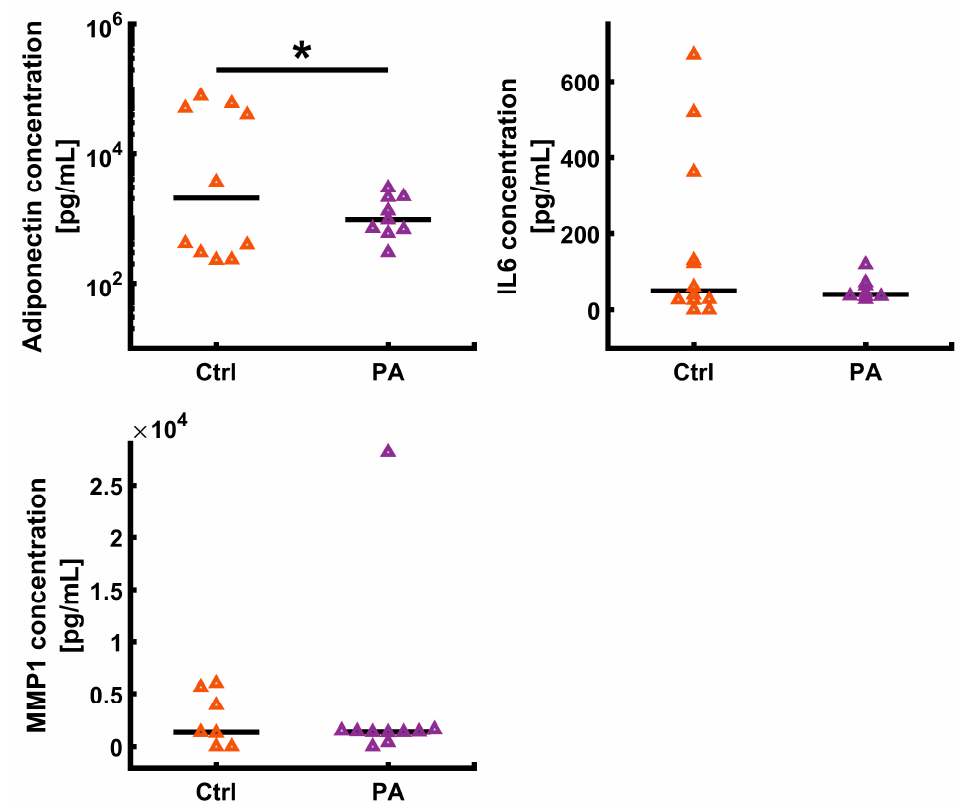
Figure 3. Cytokine evaluation from cell media was completed via ELISA. Cell media was collected after week 8 of culture. All values were corrected by a zero standard and values below detection limit were set to zero. All values were determined from four-parametric logistic curve fits. Data is shown as medians (black bars) and individual data points (triangles). Sample numbers varied for each assay due to limited culture volumes. Adiponectin: for each condition n = 10. IL-6: control n = 12 and photoaged n = 8; MMP1: control n = 7; and photoaged n = 10. A two-tailed t -test showed a significant decline in the adiponectin secreted into media after photoaging AVHSEs ( p < 0.05; indicated with *).